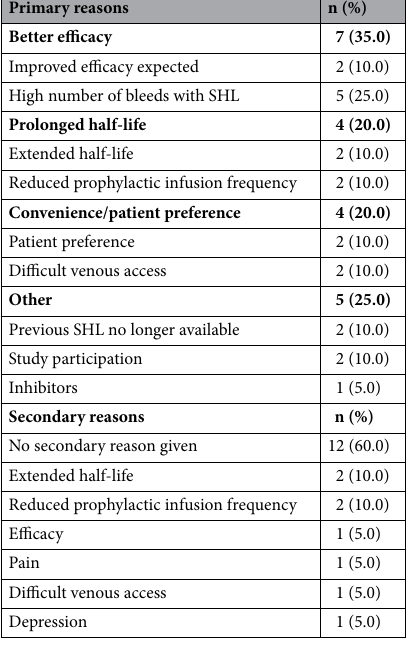
Table 2. Reasons for switching to EHL (n = 20). Summary of the primary and secondary reasons for persons with SHA switching from SHL to EHL (rFVIII-Fc, Elocta).